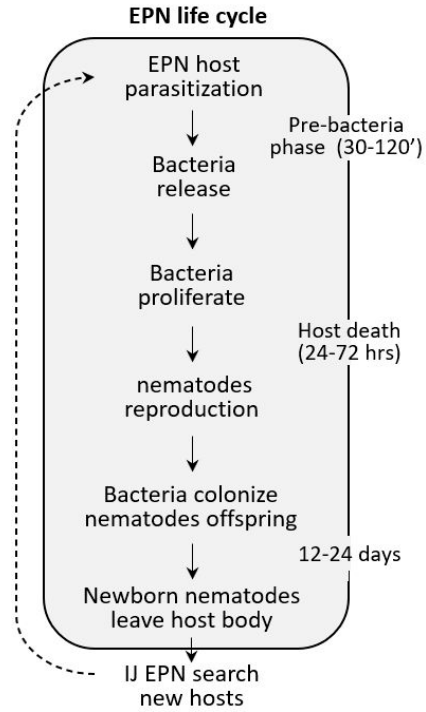
Figure 7. Entomopathogenic nematode (EPN) life cycle. During the IJ3 stage, the nematode penetrates the host; after 30 min to 2 h, symbiont bacteria are released in the hemolymph, bacteria proliferate, and the insect dies within 24–72 h. After reproduction, nematode offspring feed on the corpse and finally leave the host and search for a new target.